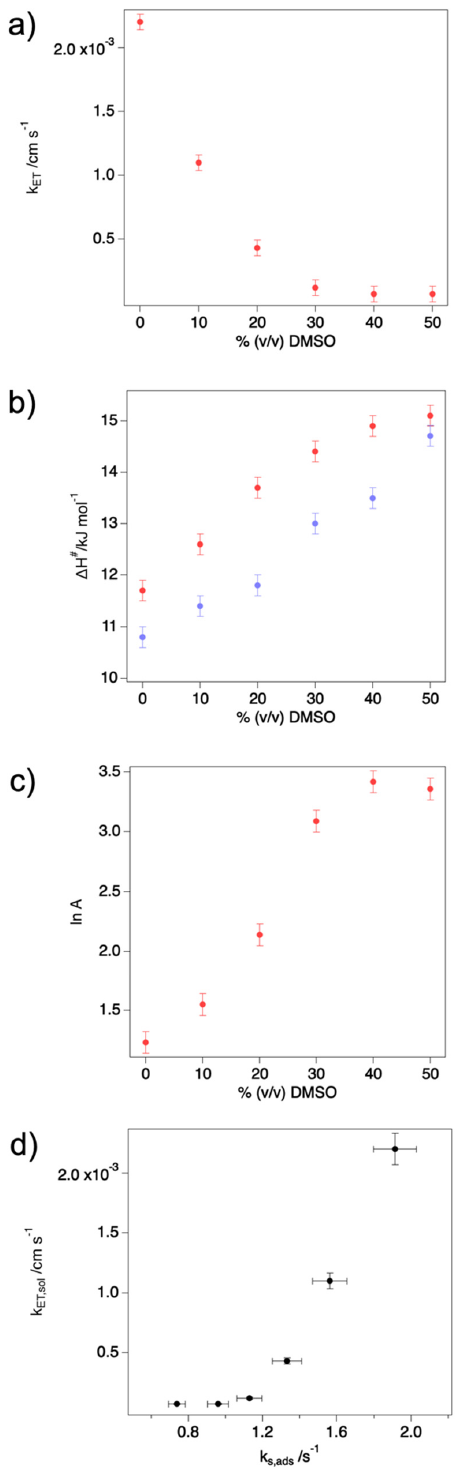
Figure 6. Dependence of k ET ( a ), ∆ H # ( b ) and lnA ( c ) vs. % ( v / v ) DMSO. In panel ( b ), the red dots refer to the protein in solution, while the lilac ones to the protein immobilized on a SAM. ( d ) Plot of the ET rate constant in solution (k ET ) vs. the corresponding value, at the same DMSO concentration, for the protein immobilized on a SAM (k s ). The data corresponding to the SAM-immobilized proteins in panels ( b , d ) are taken from ref. [44].